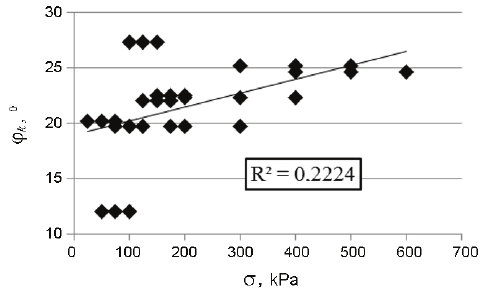
Fig. 11. The angle of internal friction versus vertical stress (results of 9